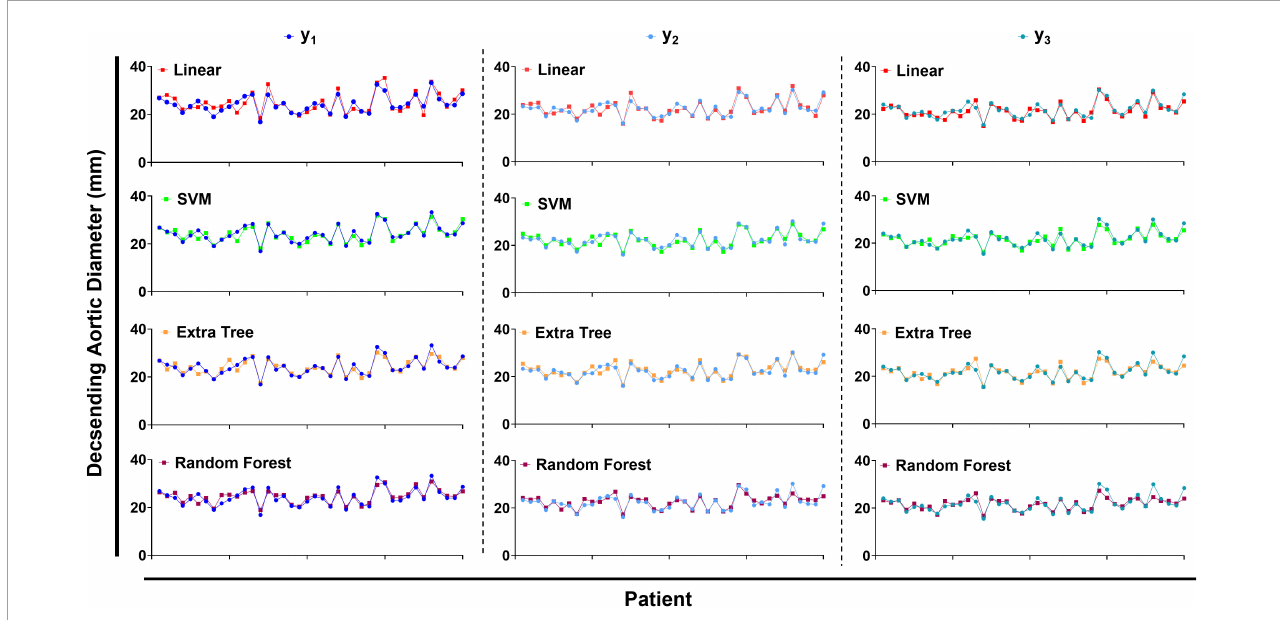
FIGURE2 The predicted values of descending aortic diameter compared with the true values. LR, linear regression. SVM, support vector regression. ETR, extra-tree regression. RFR, random forest